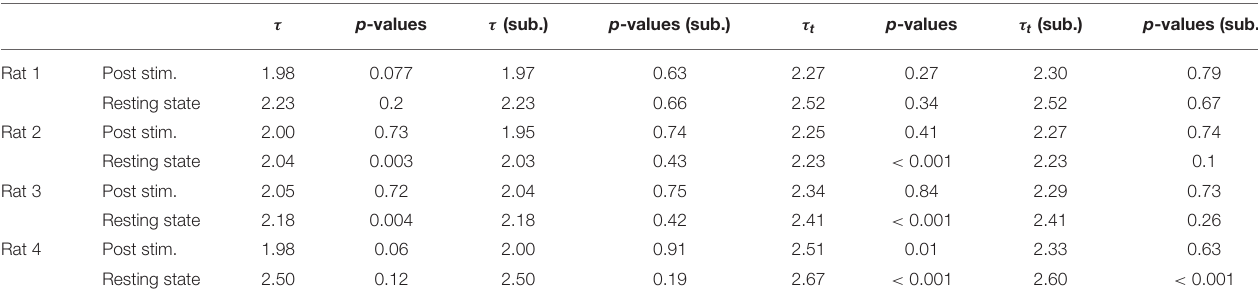
Resting state Rat 5 Post stim.